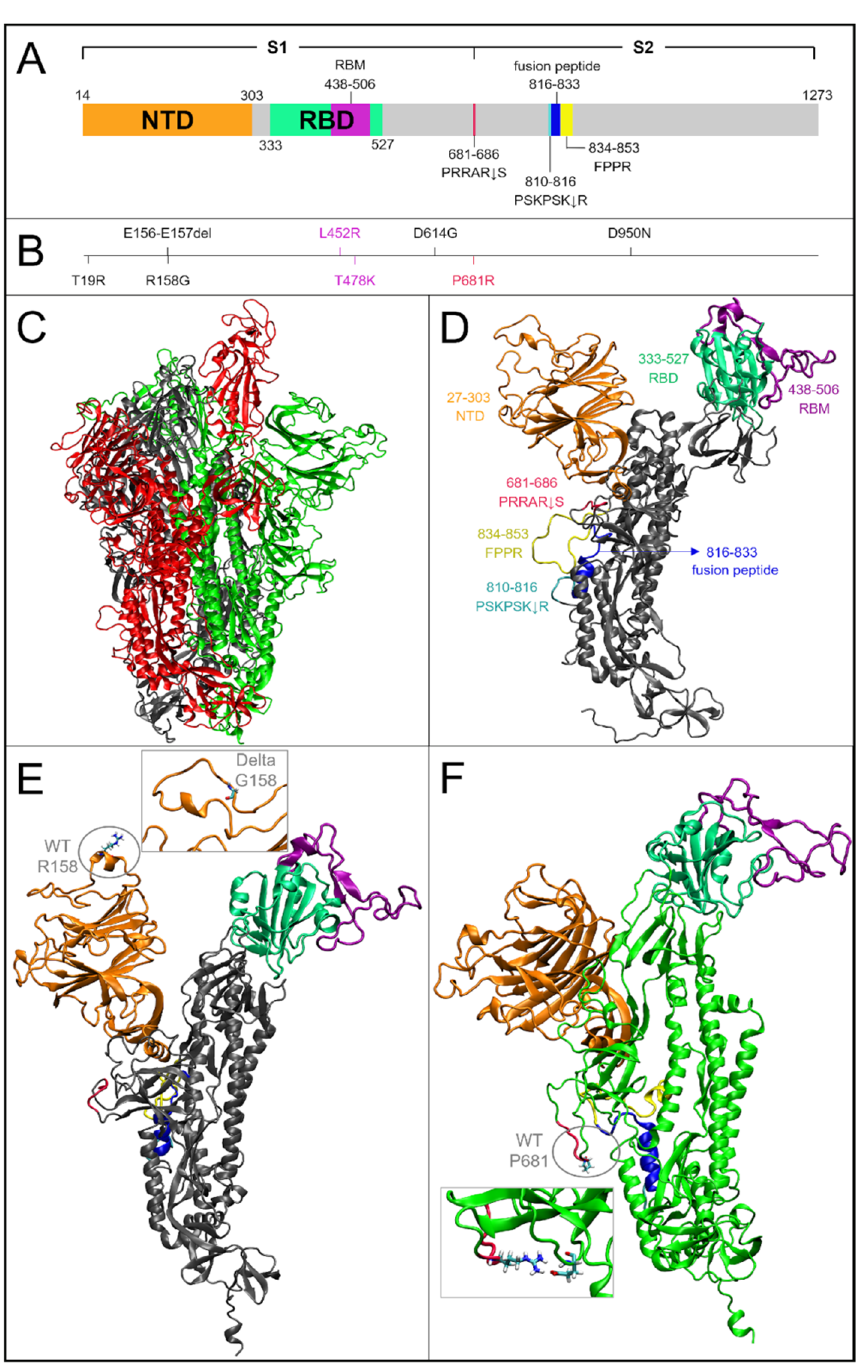
Figure 1. Domain organization and structural differences between the WT and Delta variant. ( A ) Graphical scheme of the spike domains from aa 14 to 1273: N-terminal domain (NTD) is repre- sented in orange; the receptor-binding domain or RBD (aa 333–527) is highlighted in green; the receptor-binding motif, or RBM (aa 438–506), which is within RBD region, is represented in purple; the cleavage sequence at the S1/S2 boundary is colored in red; and the second cleavage site, the fu- sion peptide and the fusion peptide proximal region (FPPR) are represented in cyan, blue, and yellow, respectively. ( B ) Representation of Delta mutations, the numbering is aligned according to panel A. ( C ) Cartoon model visualization of the WT representative frame (629.8 ns of MD simula- tion) selected by cluster analyses. The monomers are colored in black, red (in up conformation), and green, respectively. ( D ) WT monomer 1 is represented with the same colors as the schematic domains in panel A. ( E ) Cartoon representation of WT monomer 1. The ellipse shows the confor- mation of the WT residue R158 and the rectangle shows the representative frame (655.4 ns) detail of the same region for the Delta variant with G158 mutation. ( F ) Cartoon representation of WT